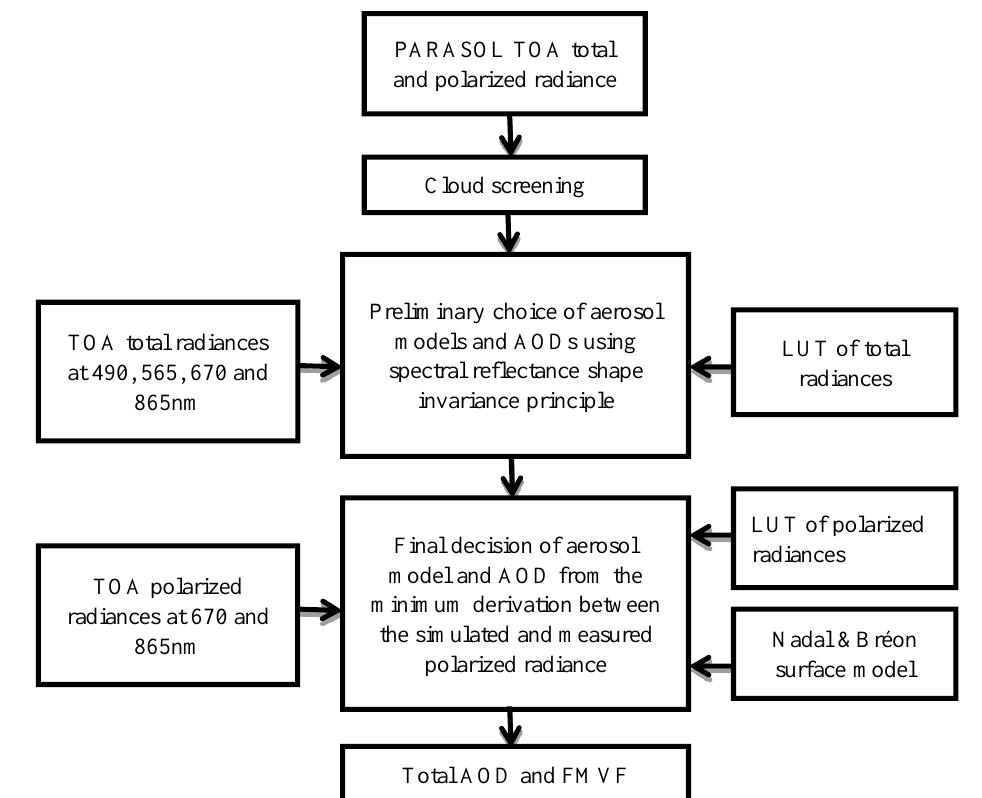
Figure 2. The flowchart of the aerosol retrieval process from PARASOL total and polarized